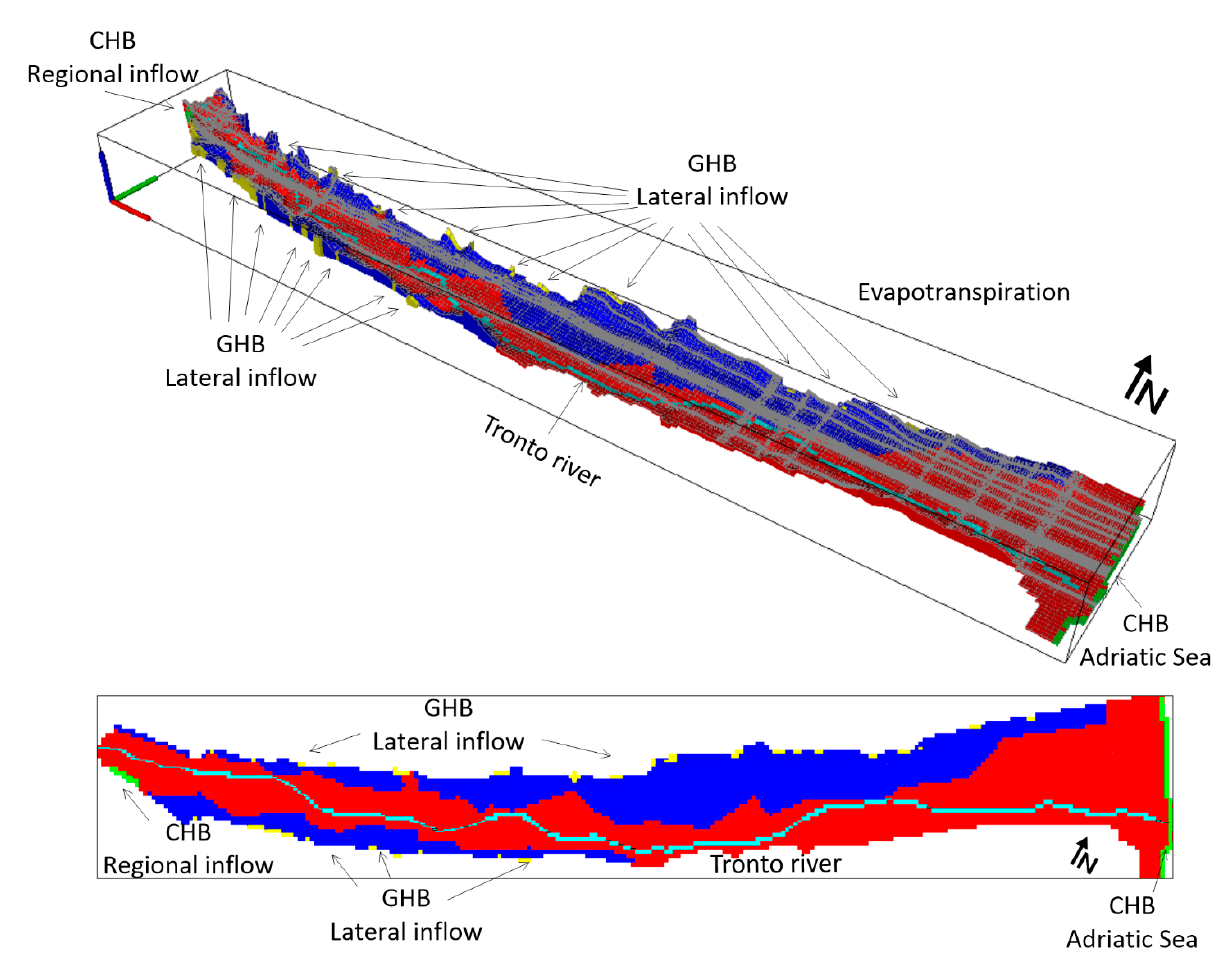
Figure 2. Three-dimensional sketch ( upper panel ) and plan view ( lower panel ) of the model grid discretization (grey lines) and the boundary conditions applied in the Tronto alluvial aquifer. The unconsolidated sandy gravel unit (red area) and the consolidated sandy gravel unit (blue area) are also represented. Vertical exaggeration 1:10.